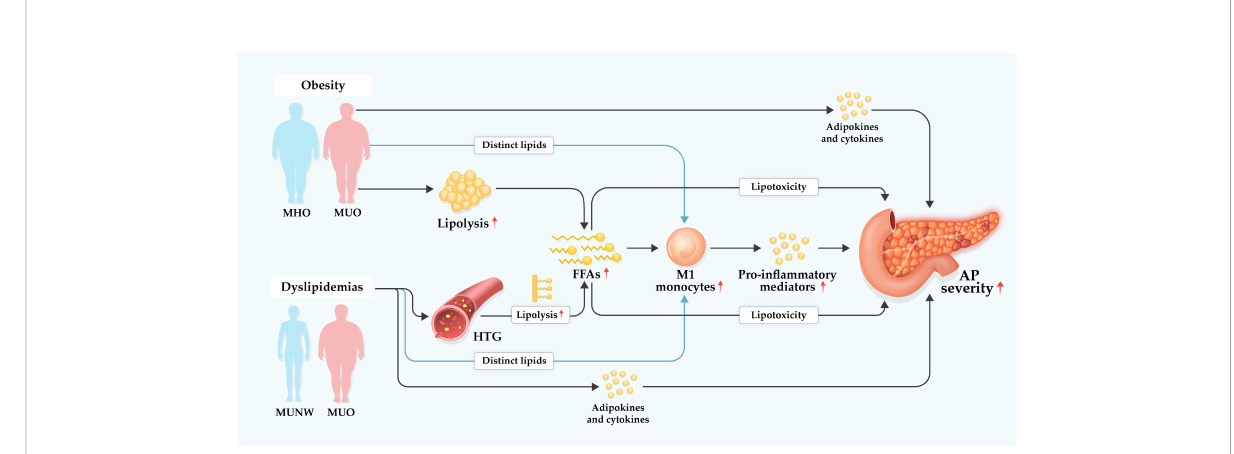
FIGURE 3 Hypothetical diagram of underlying mechanisms of obesity and dyslipidemias in aggravating acute pancreatitis. Dyslipidemias are prevalent in individuals with metabolically unhealthy obesity (MUO) or metabolically unhealthy normal weight (MUNM), but less prominent or even absent in individuals with metabolically healthy obesity (MHO). Hypertriglyceridemia (HTG), a common form of dyslipidemias, is one of leading etiologies of acute pancreatitis (AP) with increasing global incidence. Obesity, particularly MUO, and dyslipidemias, especially HTG, may exacerbate AP severity in several complex multifactorial ways. Excessive free fatty acids (FFAs) are accumulated via elevated lipolysis of visceral adipocyte triglycerides during AP. FFAs possess regulatory effect on monocytes and may promote their M1 polarization which induces increased production of pro-in fl ammatory mediators, resulting in ampli fi ed systemic in fl ammation. Of note, local and systemic lipotoxicity of FFAs can directly cause tissue damage and multiple organ failure in AP. Besides FFAs, other distinct lipid species may modulate generation and function of monocytes in AP. Furthermore, various adipokines and cytokines with enhanced secretion in MUO and dyslipidemia are involved in boosting systemic in fl ammatory response that contributes to aggravated severity of